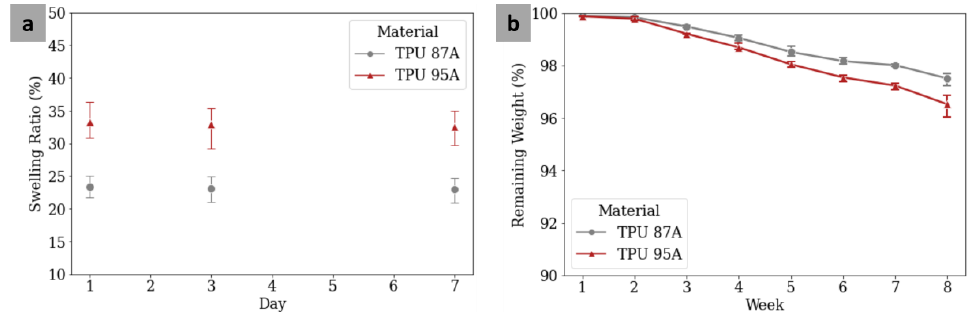
Figure 8. Swelling ratios of MTDR TPU 87A and TPU 95A after 1-day, 3-day, and 7-day immersions in PBS ( a ). Remaining weights of MTDR TPU 87A and TPU 95A after degradation tests using SBF for 8 weeks ( b ).